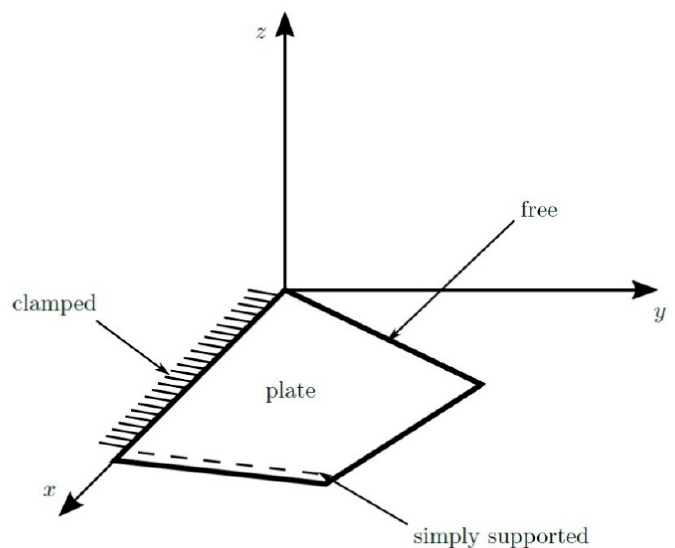
Figure 1. Example of plate.